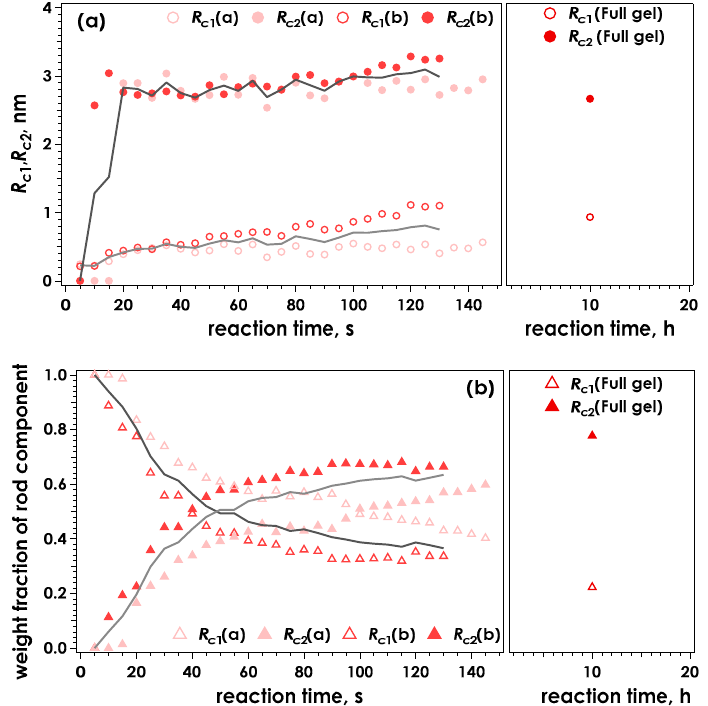
Figure 4. Time course for the calculated radii of the two rod components, R c1 and R c2 ( a ) and the corresponding weight fractions of the two components ( b ) determined by evaluation of the data presented in Figure 3 using a broken rod model. The solid lines indicate the averaged values for the two measurements.